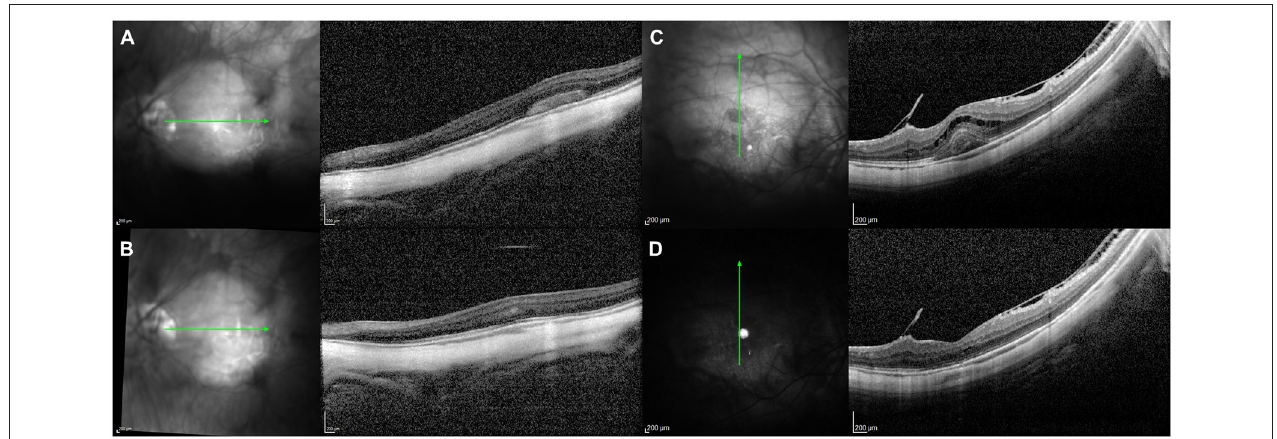
FIGURE 6 | Illustrative examples of myopic spontaneous subretinal hemorrhages. (A,C) show high density subretinal material corresponding to hemorrhage overlying an intact layer of retinal pigment epithelium (RPE). (B,D) represent the corresponding images evidencing complete resolution after 8 weeks of follow-up with no evidence of subretinal scar or RPE